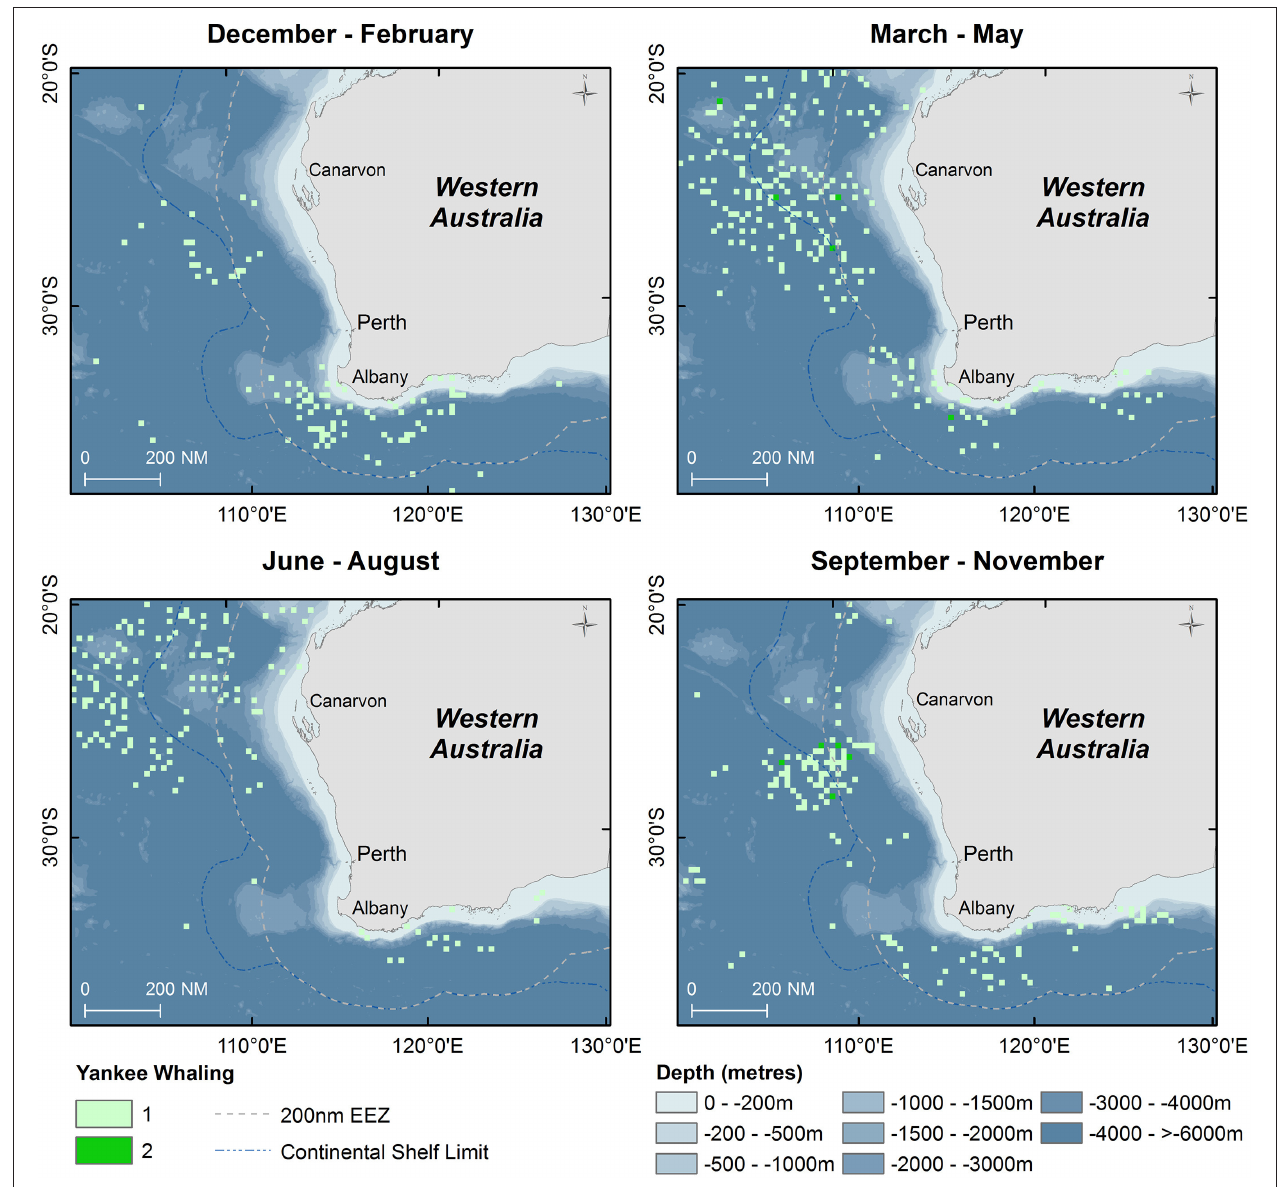
FIGURE 5 | Point density maps displaying seasonal distribution of sperm whales taken during Yankee whaling operations (Townsend, 1935) with shaded symbols indicating number of animals taken in 15 nautical mile grid cells.